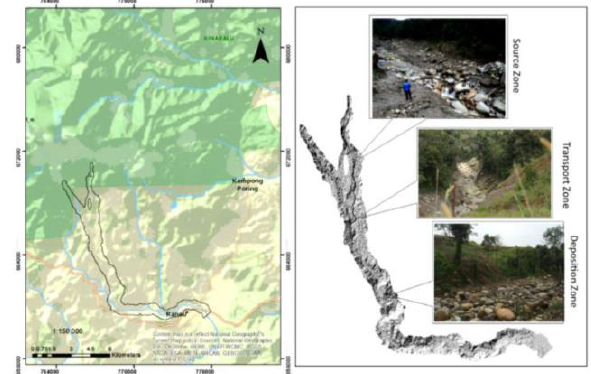
Figure 1. Location of study area at Mesilau River in Kundasang region which was struck by debris flow in June 2015 The area is in a typical tropical climate, large amount of rainfall throughout the year. The annual rainfall ranges from 1920 mm to 3190 mm (average 2075 mm) (Tating et al.,